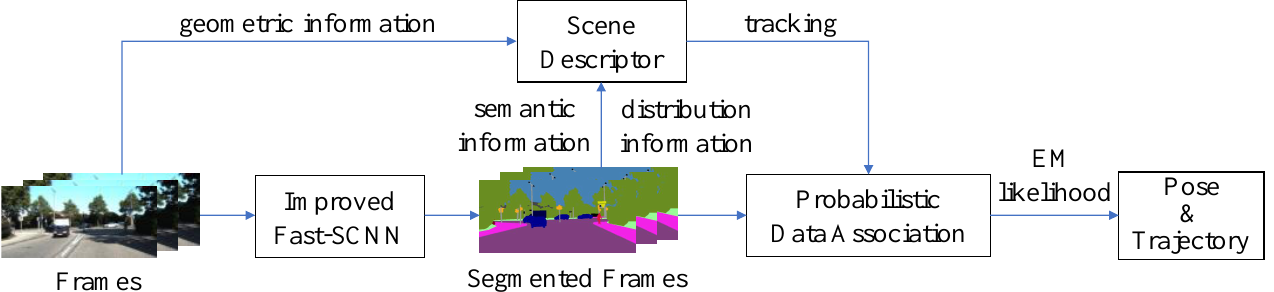
Figure 1. System overview, showing all the steps performed in semantic segmentation, scene description, and probabilistic data association.